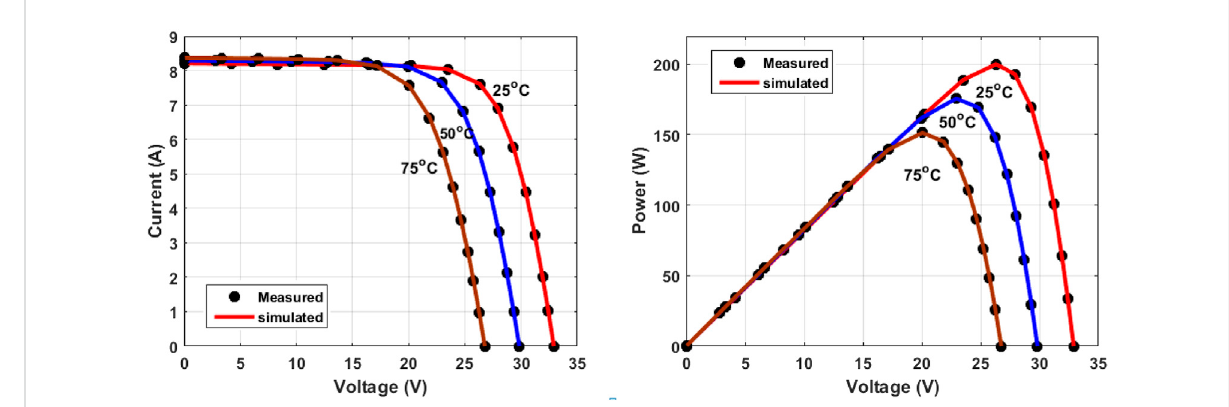
FIGURE 10 I – V and P – V curves of KC200GT at different temperatures.